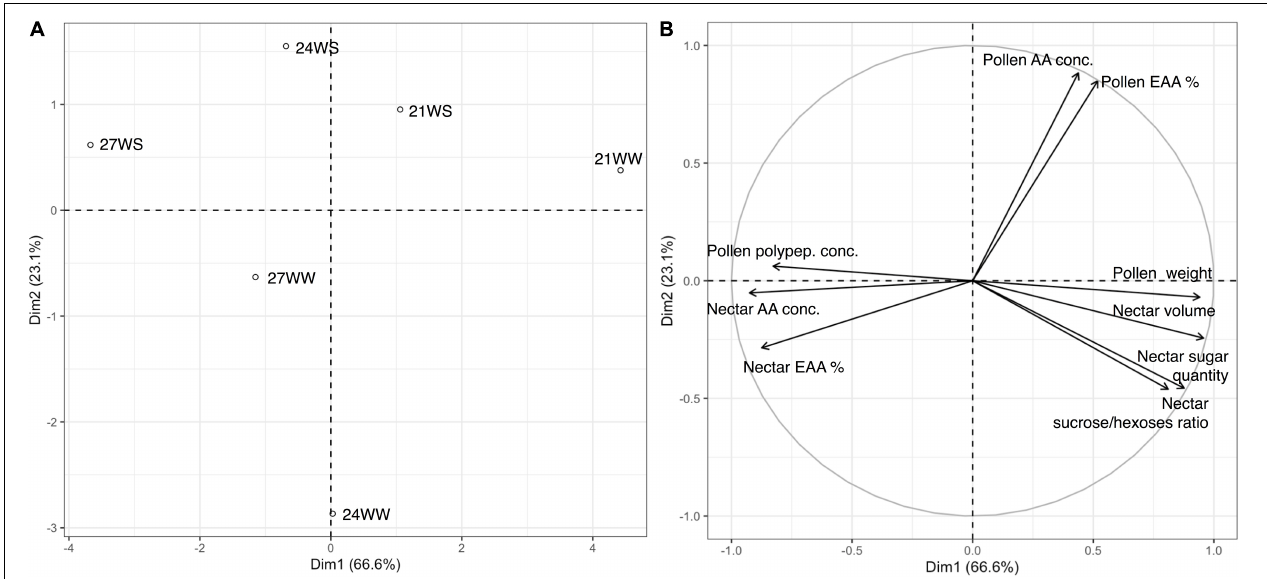
FIGURE 1 | Principal component analysis (PCA) of nectar and pollen resource measurements from Borago officinalis plants grown under different temperature regimes (21, 24, and 27 ◦ C) and watering regimes (WS, water-stressed; WW, well-watered): (A) treatment centroids; (B) variable loadings of PCA 3 weeks after stress induction. Polypep., polypeptides; Conc., concentration; %, percentage; EAA, essential amino acids.